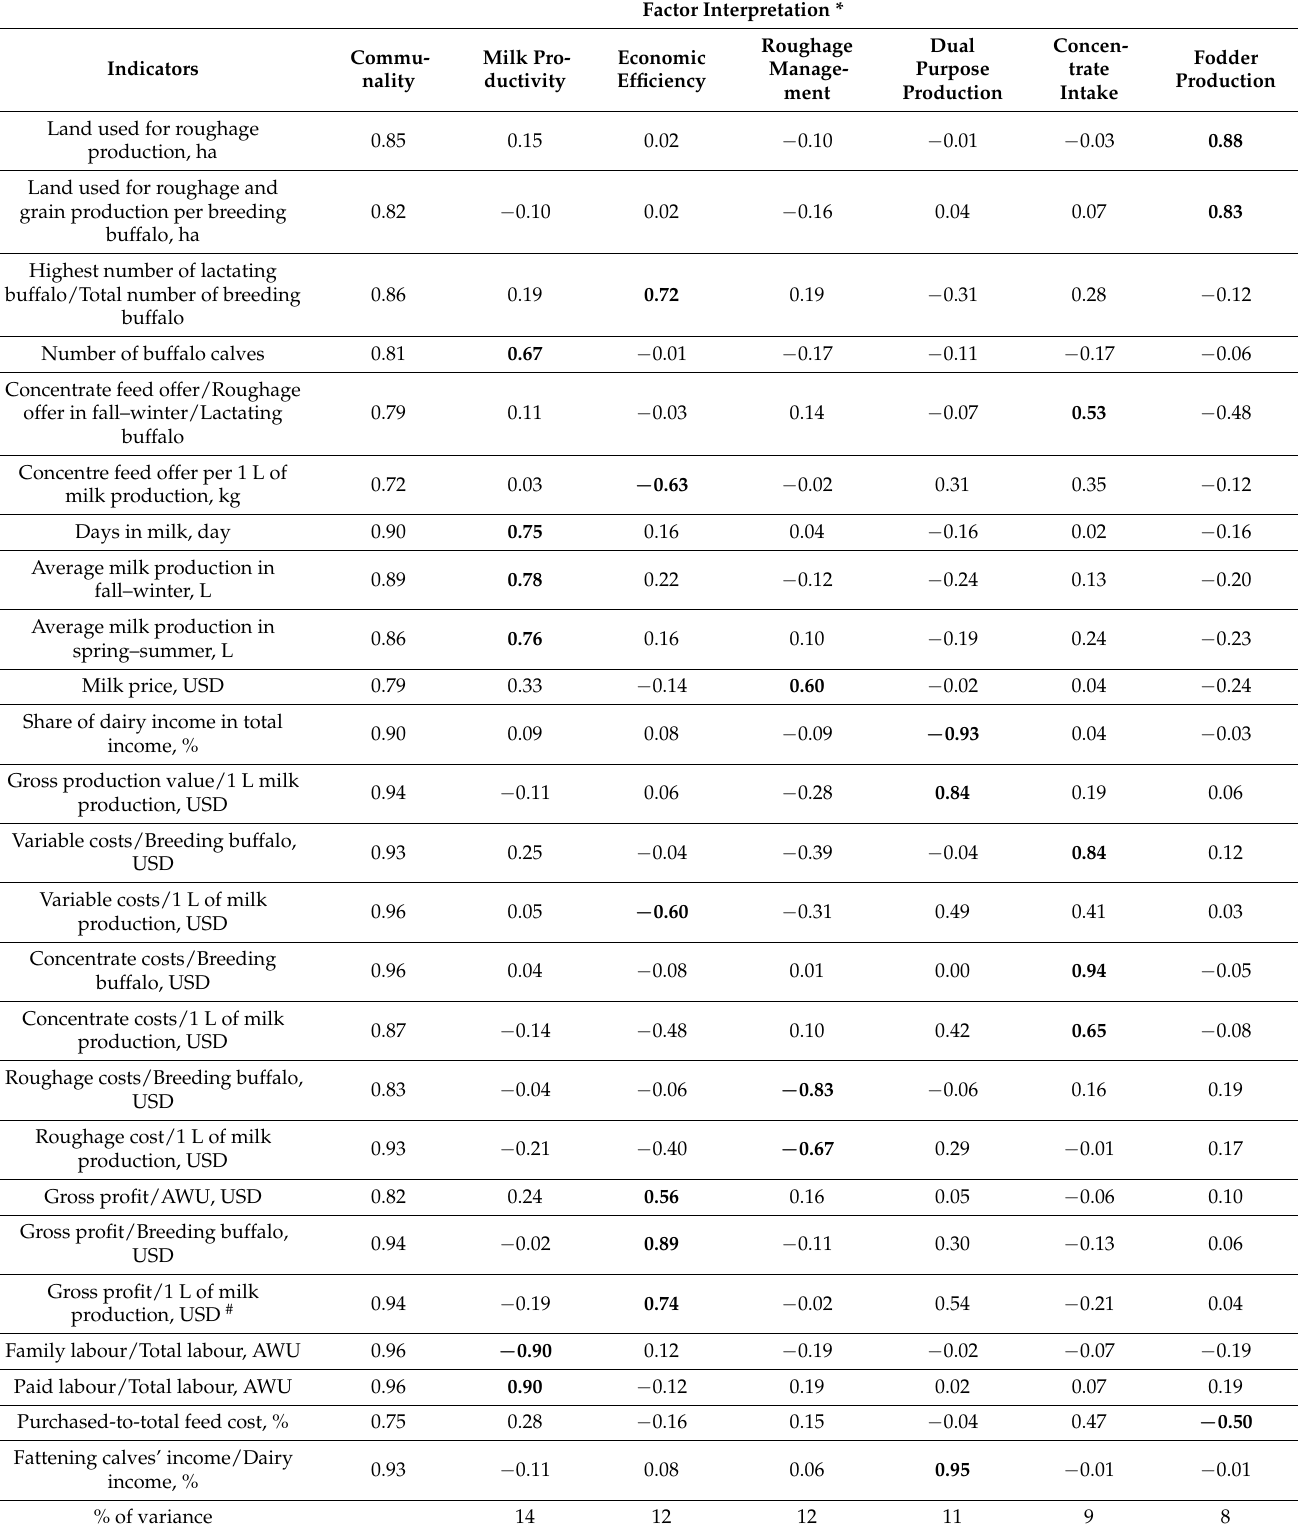
Table 4. Factor loadings for original indicators after varimax-rotated extracted